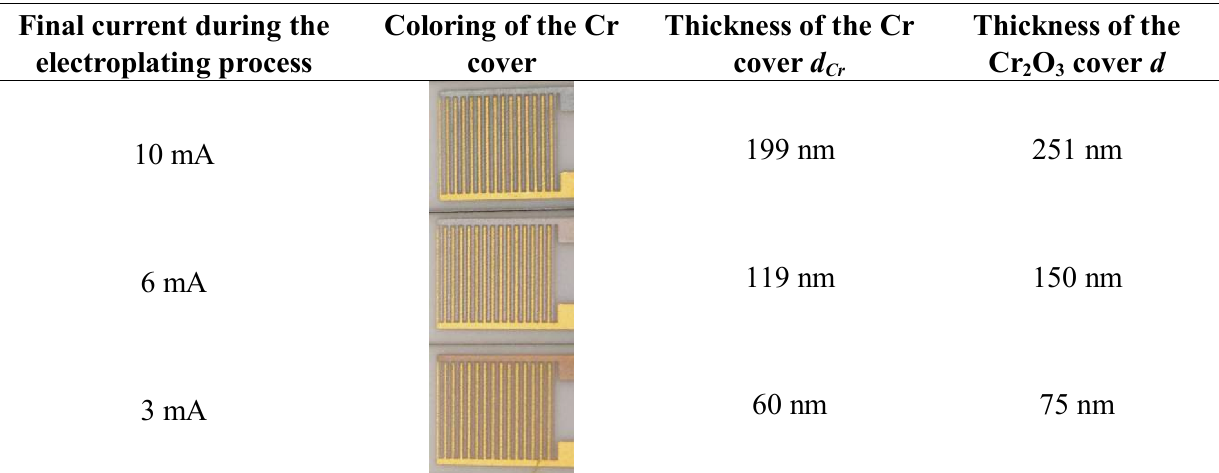
Table 1. Results of the Cr